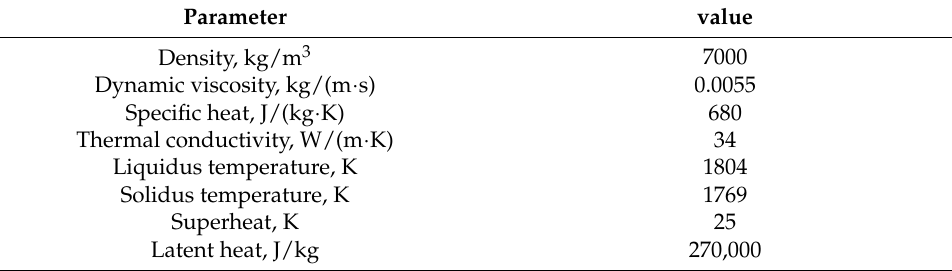
Table 3. Thermo-physical properties of steel used for numerical